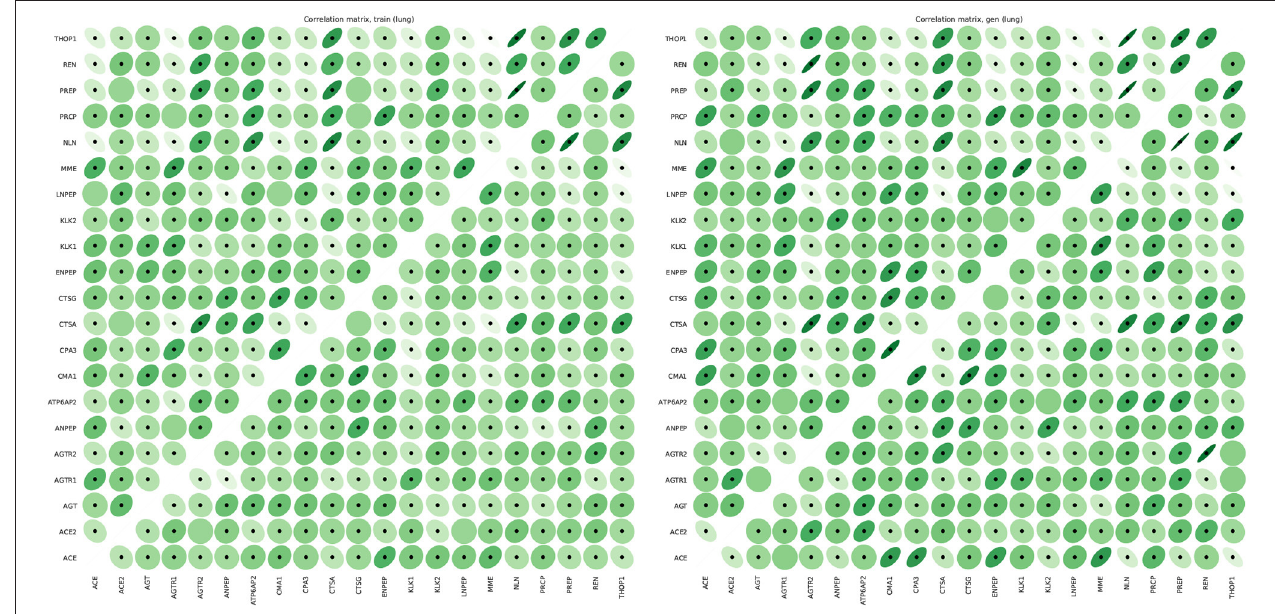
FIGURE 9 | Pairwise Pearson correlations between genes in the renin-angiotensin system pathway in lung for real (left) and synthetic (right) data. The correlations in the lower and upper matrices are computed from samples with low (61 samples) and high (60 samples) ACE2 expression, respectively. We use dots to label statistically significant correlations (two-sided p -value < 0.05).